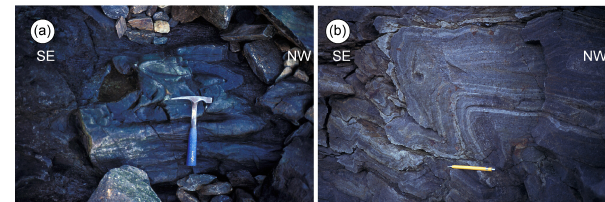
Figure 11. Non-cylindrical minor fold associated with the basal thrust: (a) sheath folds with apical axes perpendicular to the sec- tion view; and (b) type 3 fold interference pattern (after Ramsay, 1967) in the phyllonitic domain (see Fig. 10 for